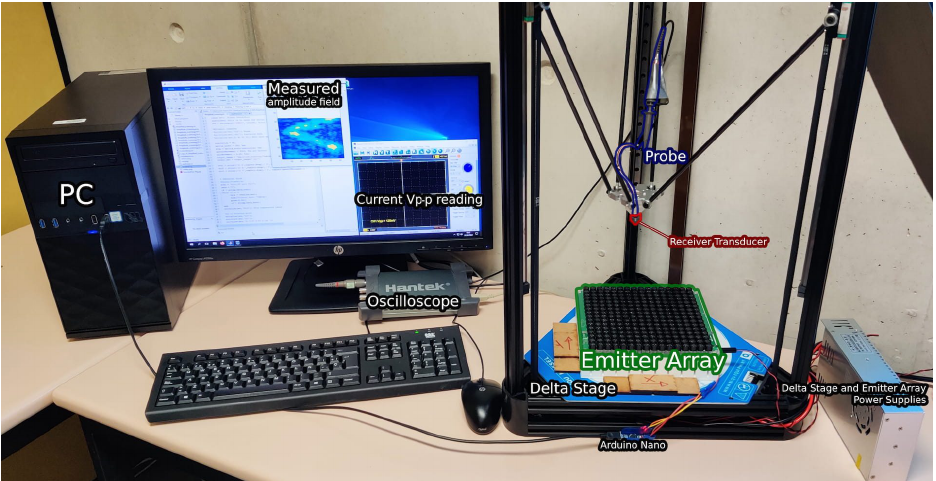
Figure 7. Experimental Setup used to scan the emitted amplitude